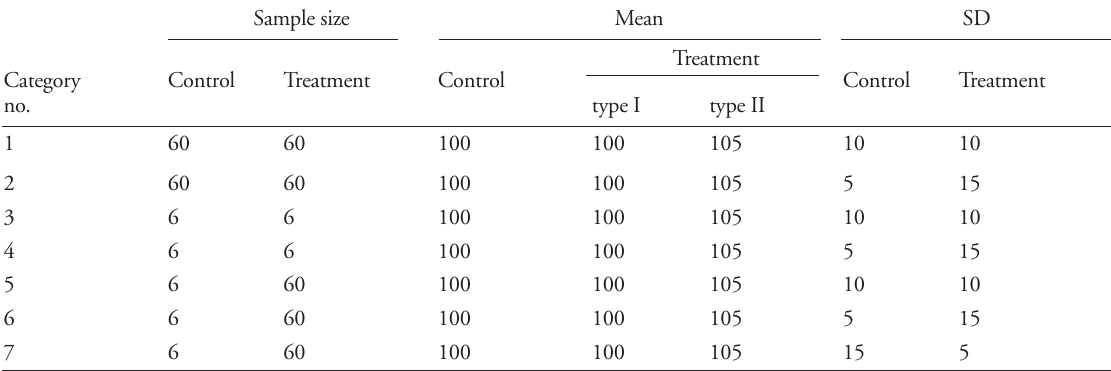
Table 1. Parameters of data categories (seven parameter combinations used with each of three distribution types).